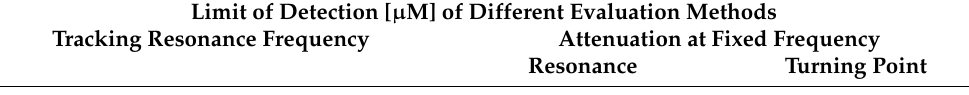
Table 2. Limits of detection of aspartic acid, glycine, lysine, and threonine measured with the vector network analyzer (tracking the resonance frequency shift vs. recording the attenuation at two different fixed measuring frequencies, the resonance frequency and the left turning point of the frequency response for UHPLC-MS grade